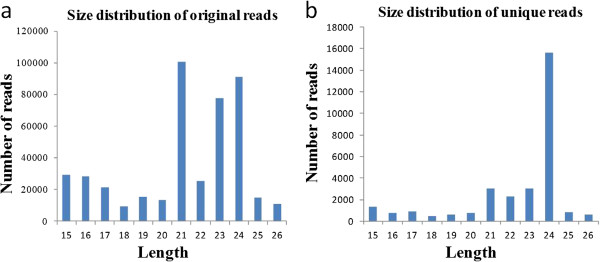
Size distribution of sequenced small RNAs.